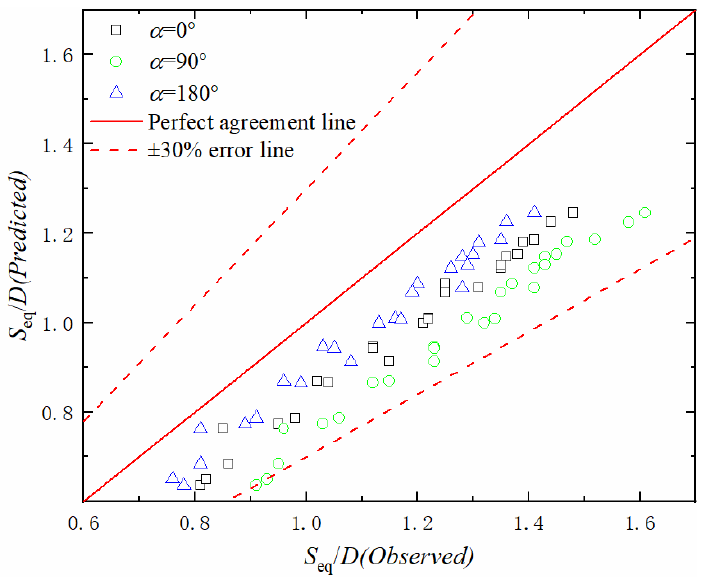
Figure 8. Comparison of experimental data and predicted values by Equation (11).